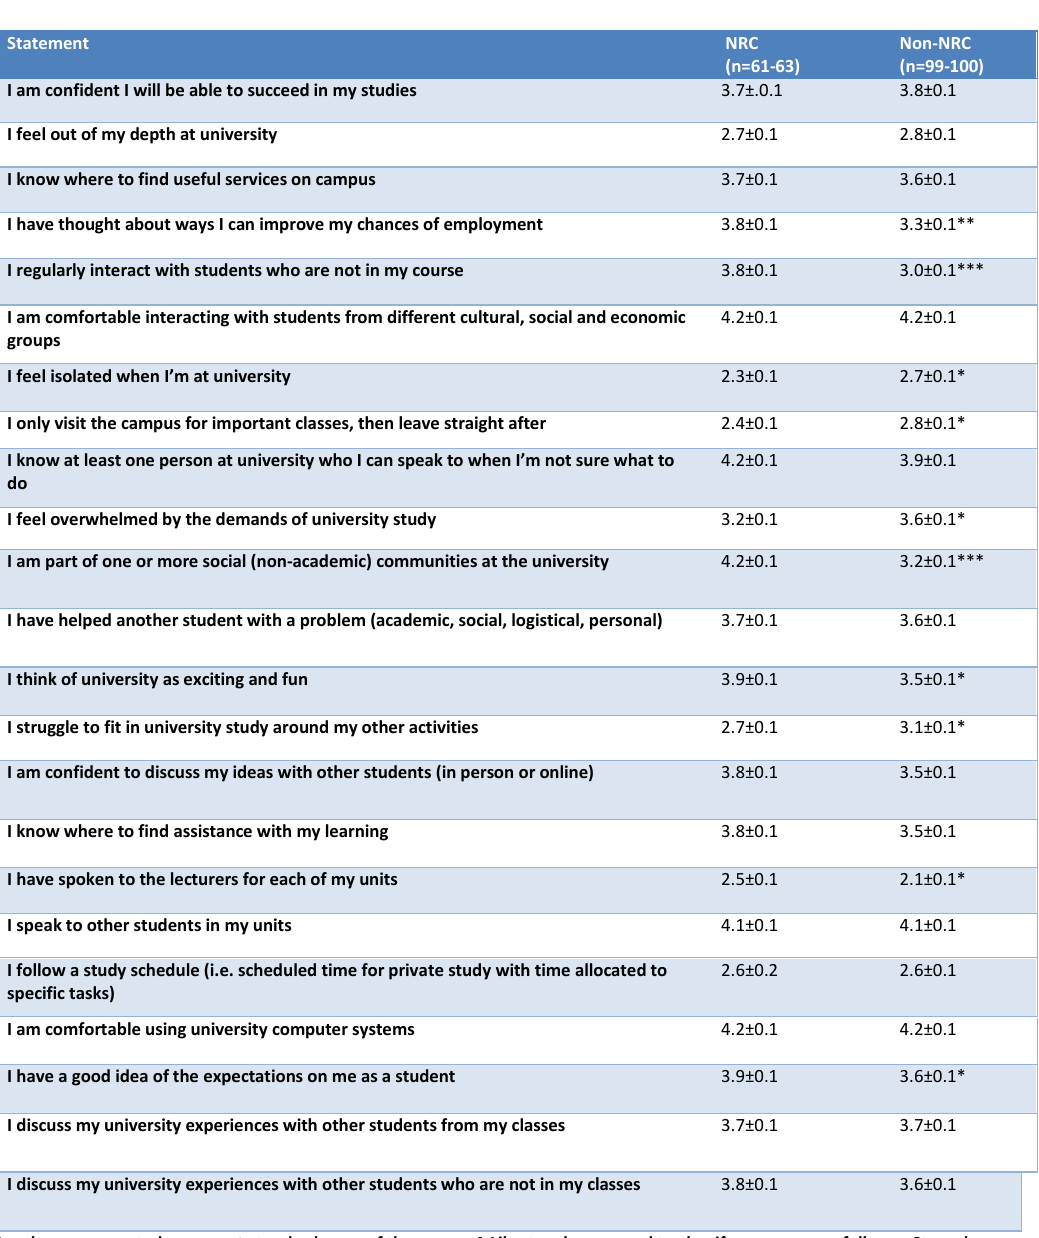
Table 4: Students' perceived confidence in a variety of competencies after the fourth week of semester